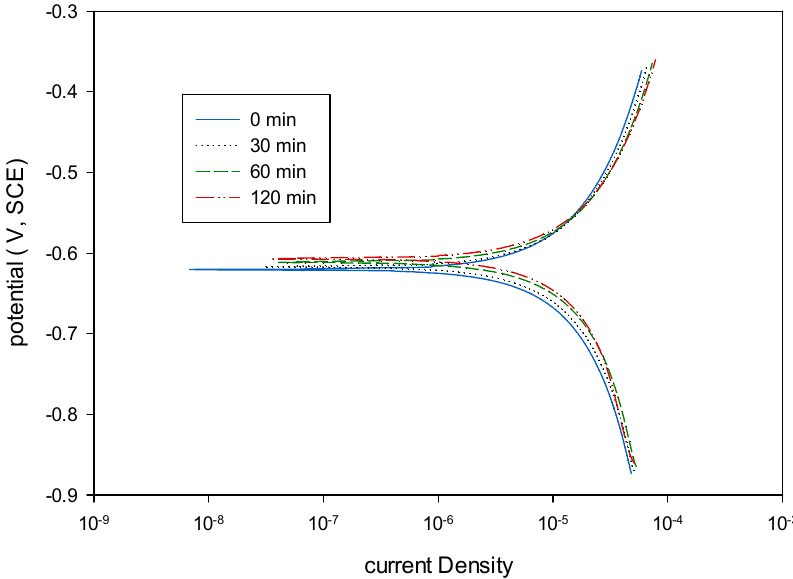
Figure 7. Potentiodynamic polarization curves of carbon steel alloy API-X120 in GTL process water at di ff erent immersion